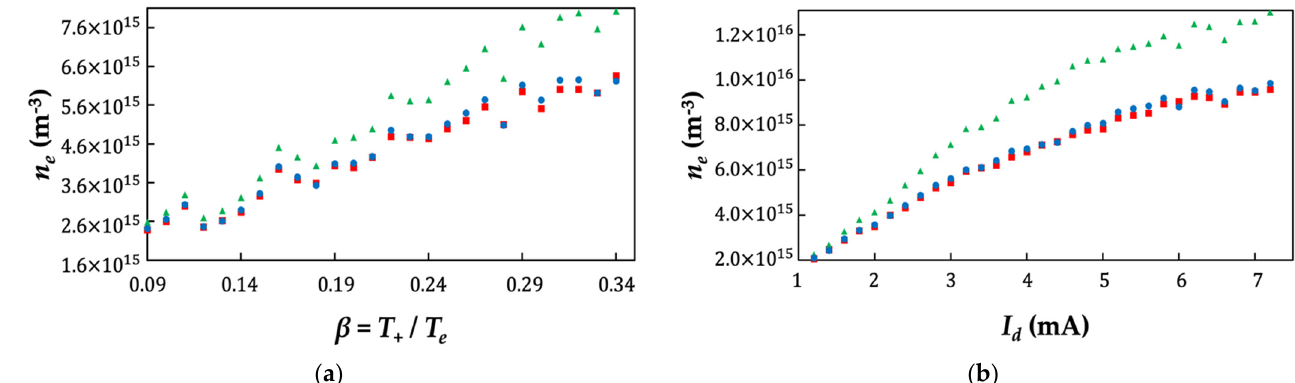
Figure 13. ( a ) Electron density obtained using different methods versus β . ( b ) Electron density obtained using different methods versus I d : red squares mean n e ( EEDF ) , blue circles mean n + ( Sonin, β (cid:54) = 0 ) and green triangles mean n + ( Sonin, β = 0 ).